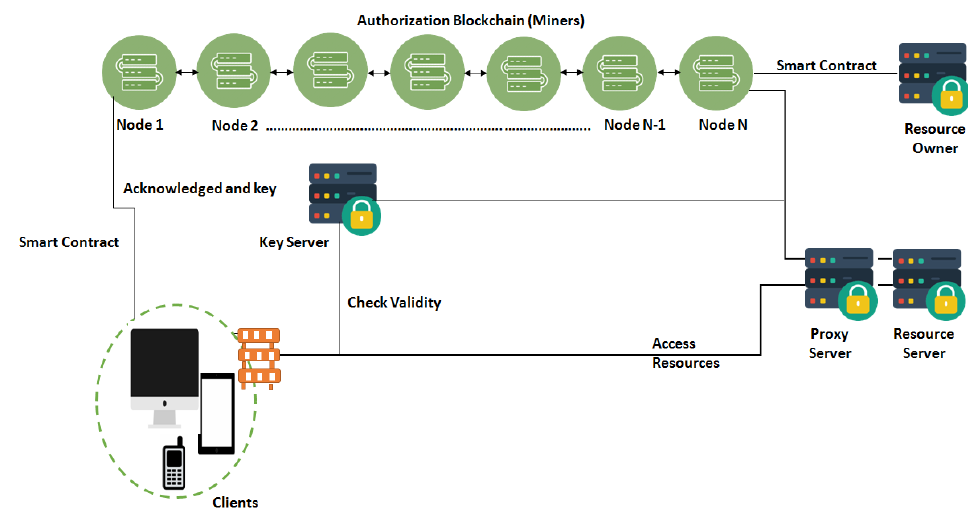
Figure 8. Blockchain